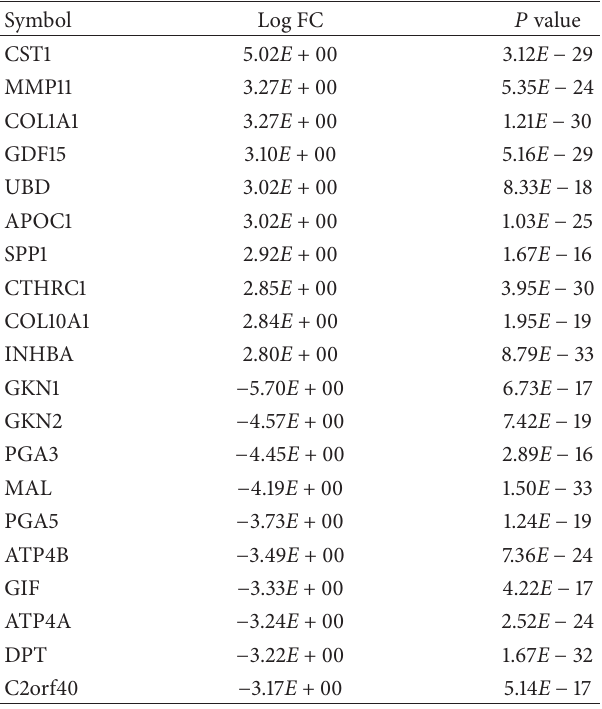
Table 2: Top ten upregulated and downregulated DEGs between gastric cancer and normal